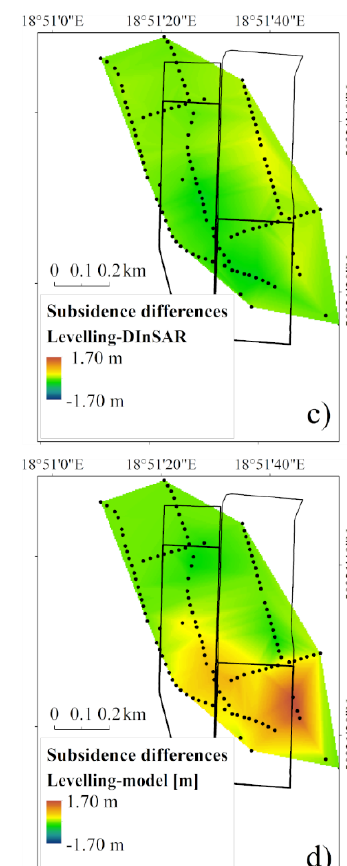
Table 2. Statistical assessment of the DInSAR (D) and model (M) data compared to the verification data from levelling (L).